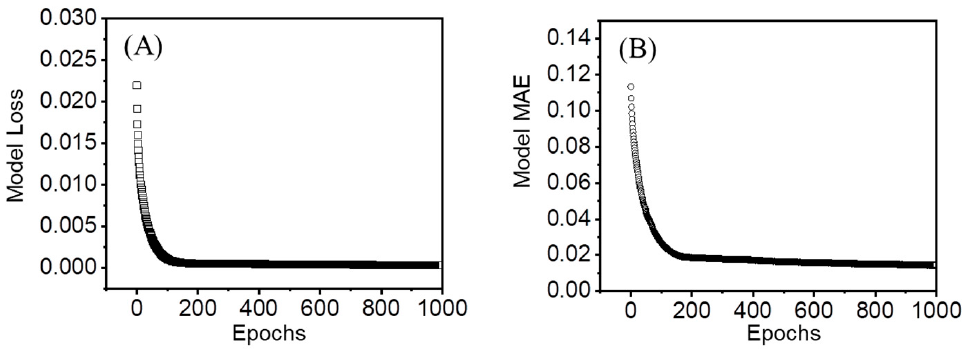
Figure 5. ( A ) The MSE loss function and ( B ) MAE function of the mass-loss percentage of degradable PLA/PHB fabrics under multiple environmental parameters.